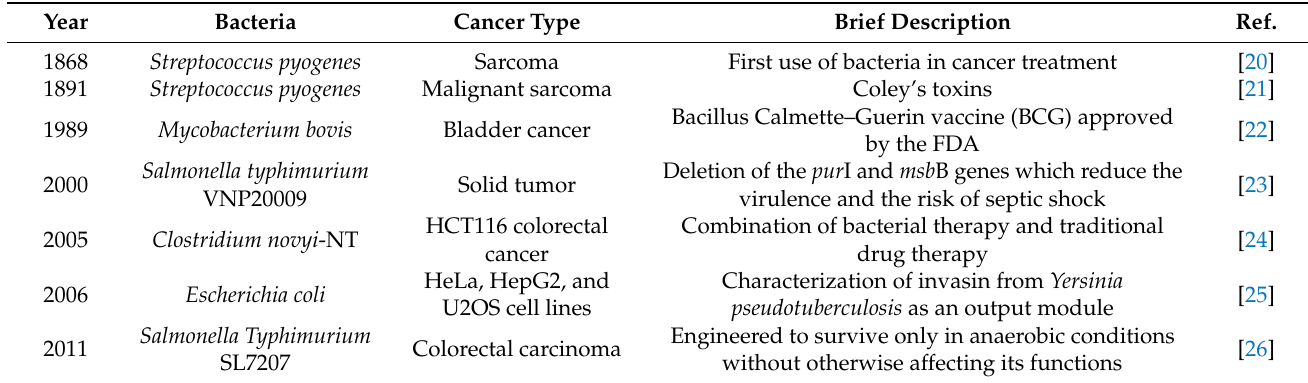
Table 1. Timeline of several typical examples of bacteria use in cancer